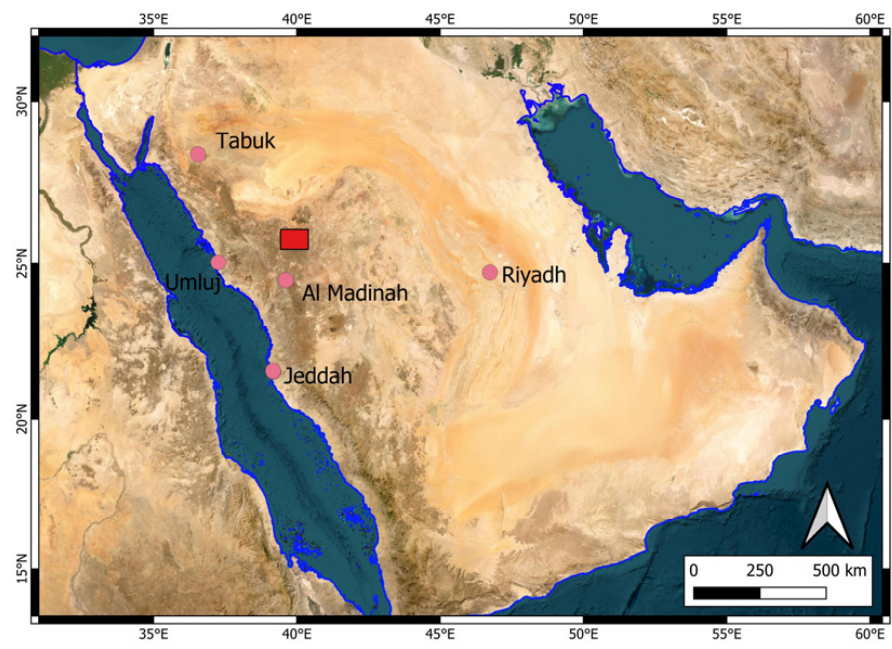
Figure 1. Microsoft Bing satellite image within QGIS shows the general landscape of the Arabian Peninsula. Note the dark zones in the western margin of the peninsula that are post-Miocene volcanic fields (harrats). Among them, Harrat Khaybar is located just north of Al Madinah city (red rectangle), and it is considered one of the largest and probably more geologically complex fields within the